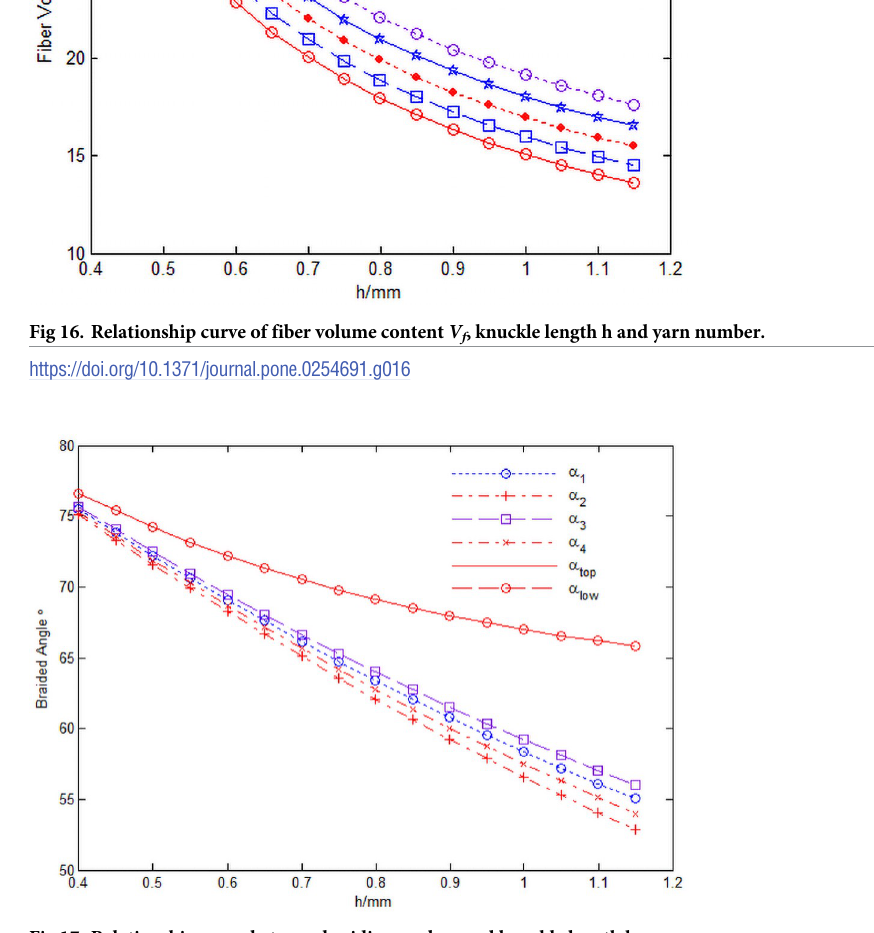
Fig 17. Relationship curve between braiding angle α and knuckle length